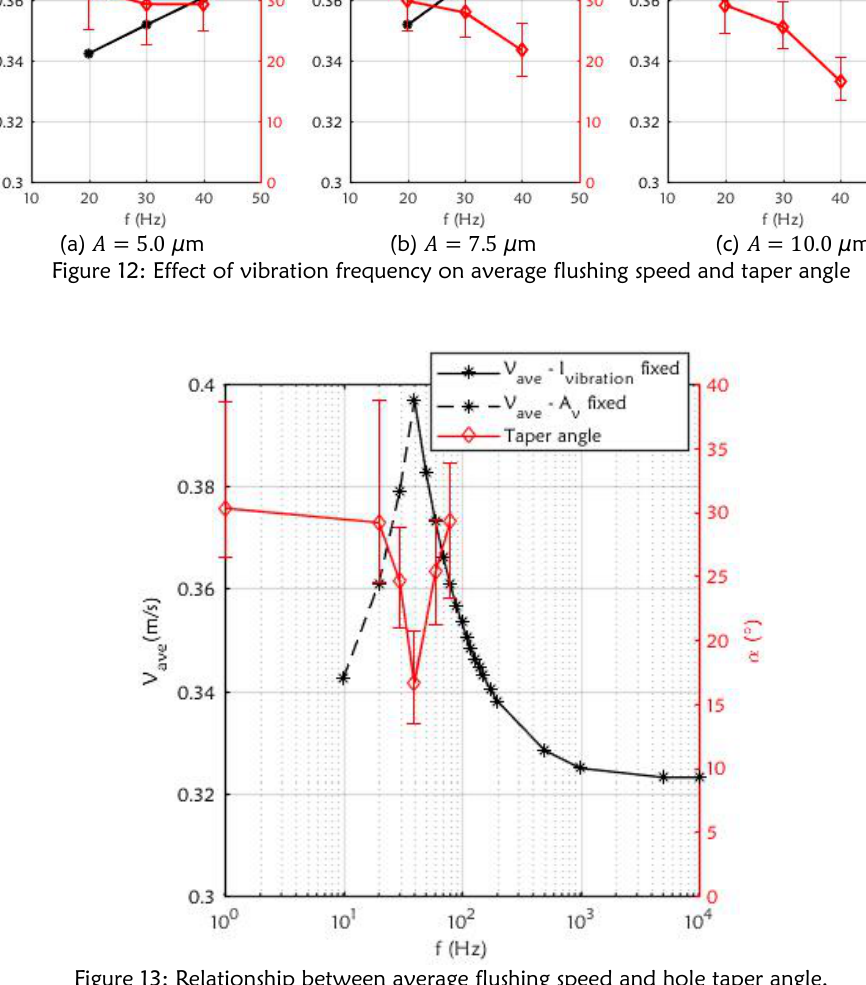
Figure 13: Relationship between average flushing speed and hole taper